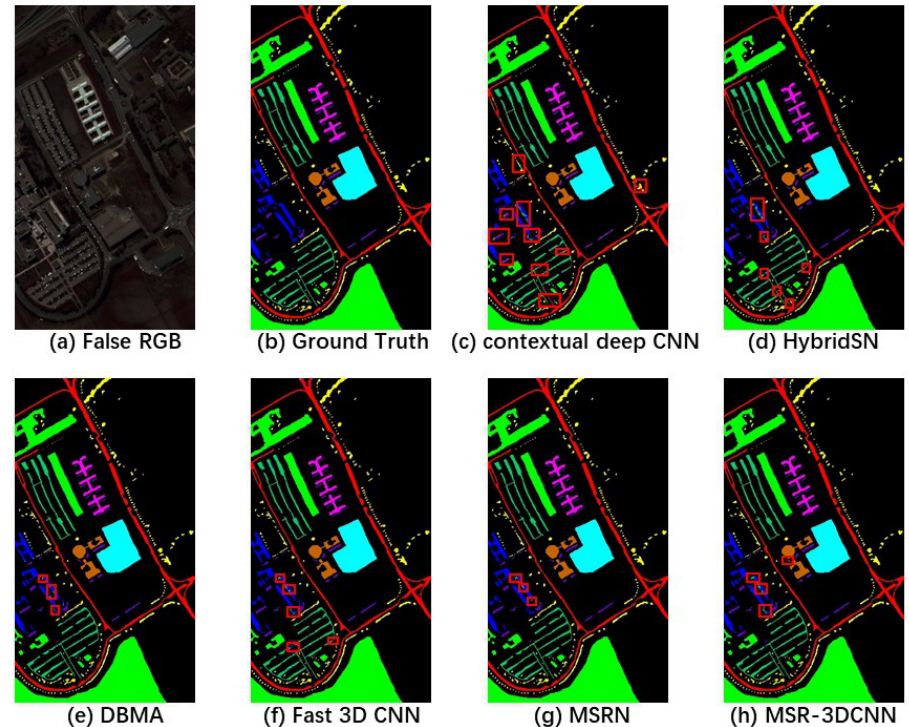
Figure 13. Results of the PU dataset using 10% samples for training and ( 9 × 9 ) patch size.